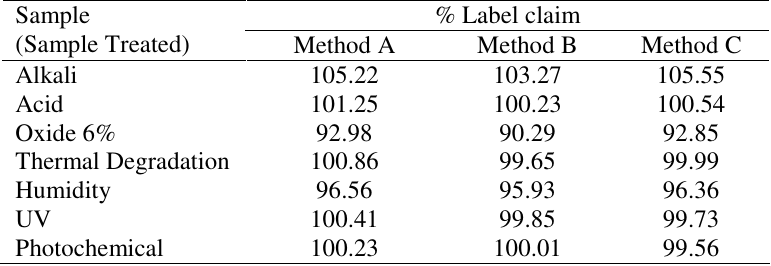
Table 4. Results of specificity